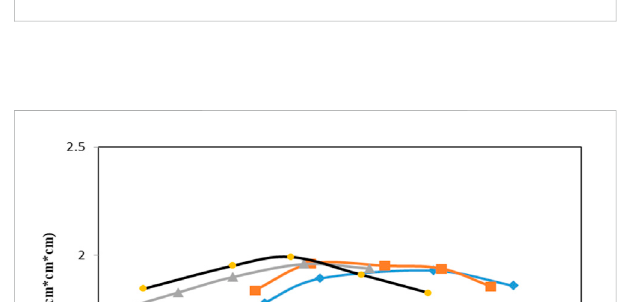
FIGURE 8 Dry density versus moisture content of different NaCl% for soil at 4.5 m